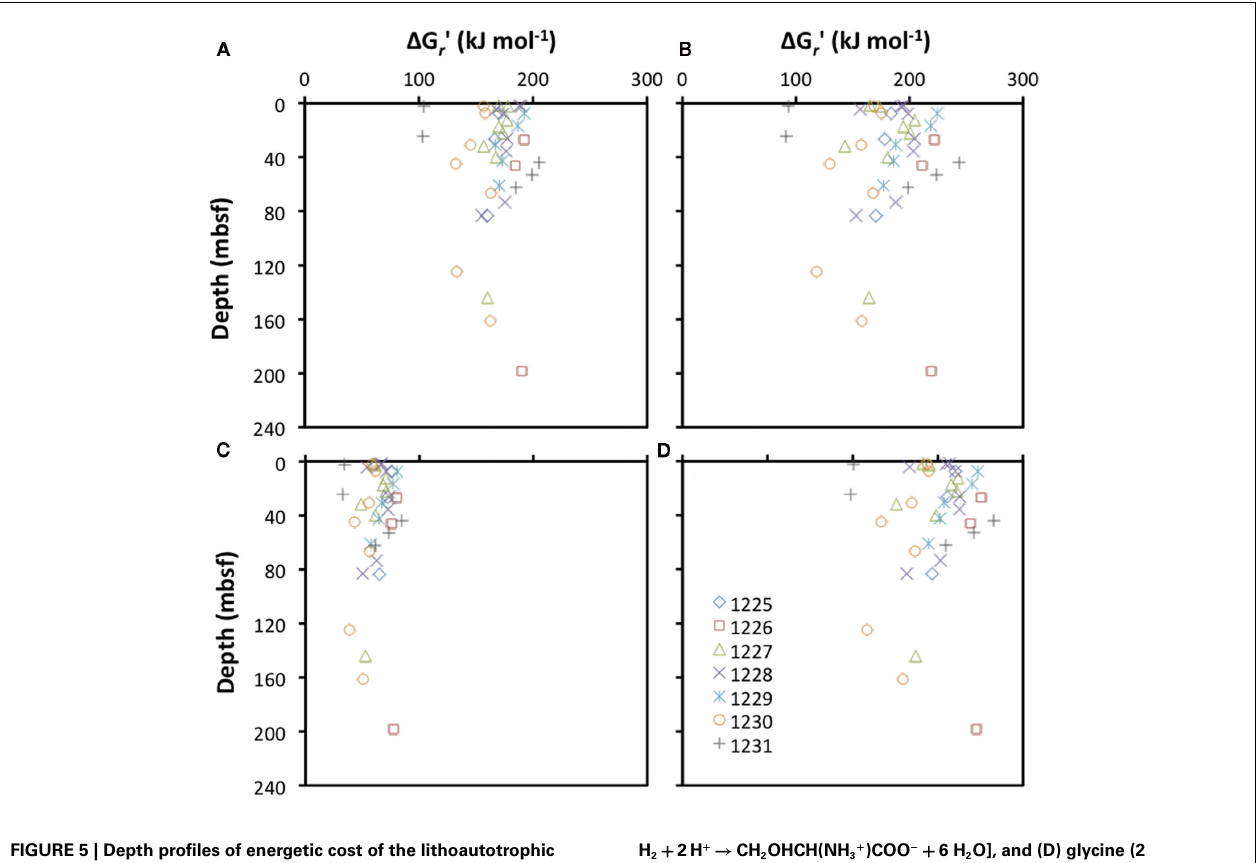
FIGURE 5 | Depth profiles of energetic cost of the lithoautotrophic synthesis of the amino acids (A) aspartic acid [asp 2 − ;